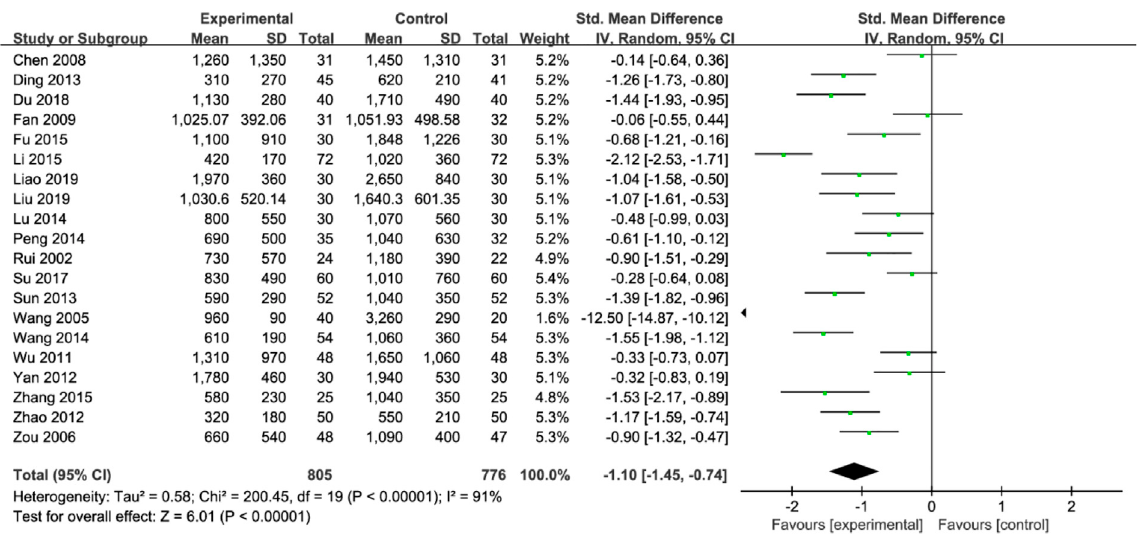
FIGURE 2 Forest plot for meta-analysis of the effect of TCM combined with Western medicine on 24-h urinary protein.